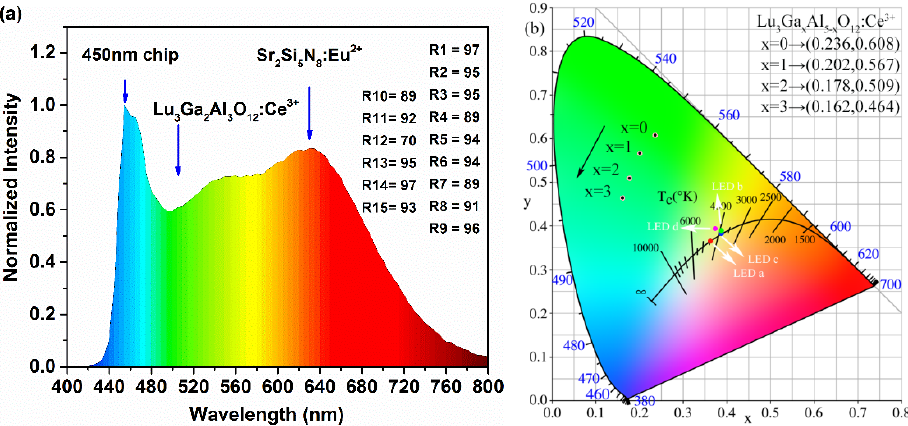
Figure 8. ( a ) The luminescence spectrum of the specimen w-LED device. ( b ) The CIE chromaticity coordinates of the Lu 3 Ga x Al 5 − x O 12 : Ce 3+ (x = 0, 1, 2, 3) phosphors and specimen LEDs a, b, c, and d.